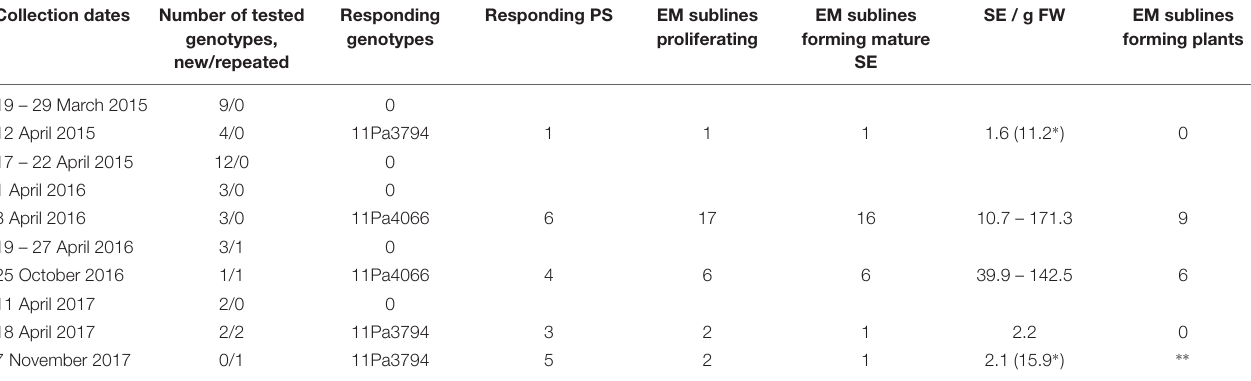
FIGURE 1 | Bud collection from somatic Norway spruce trees and primordial shoot (PS) excision. (A) Norway spruce somatic trees growing in an experimental plantation at Punkaharju, Finland in the spring 2018. (B) Four years old somatic tree at the first shoot bud collection on April 1, 2016. (C) Shoot buds before removal of the outermost scales and disinfection. (D) Shoot bud cut longitudinally. (E) Quarters of the PS before being placed on the culture medium. Bars: (A) = 1 m, (B) = 50 mm, (C) = 10 mm, (D) = 1 mm, (E) = 0.5 mm. TABLE 1 | Norway spruce shoot bud collection dates, number of genotypes tested, responding genotypes and the number of EM